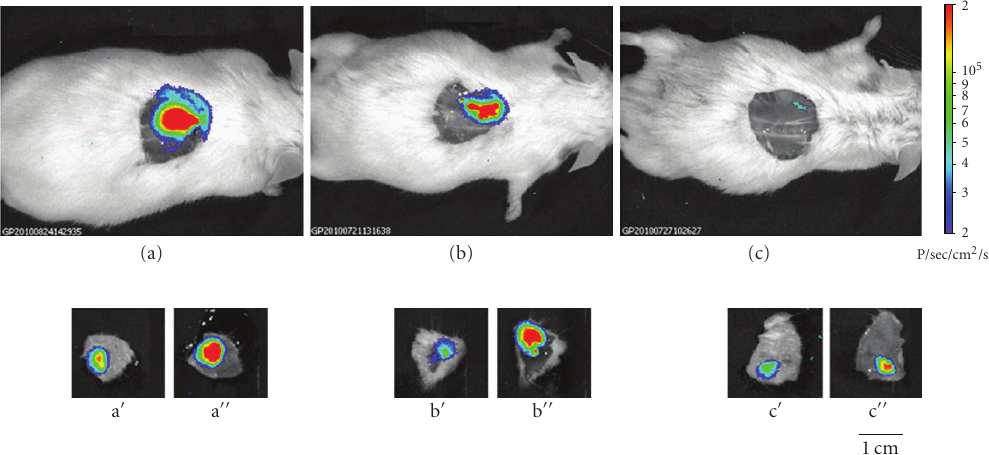
Figure 6: Biodistribution after topical administration at the wound site of AT-SCs expressing luciferase. BLI imaging of representative animals sacrificed 1 (a), 10 (b), and 15 (c) days after topical administration of luciferase-expressing cells at the wound site ( n = 3). The region surrounding the wound was excided and BLI performed both with the skin facing the CCD camera (a (cid:5) , b (cid:5) , and c (cid:5) ) and on the opposite orientation (a (cid:5)(cid:5) , b (cid:5)(cid:5) , and c (cid:5)(cid:5) ). At all time points, cells are mainly located in the lesion area with minimal spreading from the site of topical